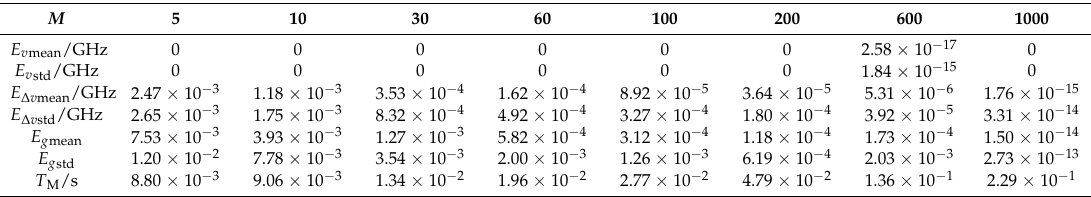
Table 4. Statistical results of errors in the key parameters extracted by the Voigt profile-based algorithm with different numbers of sample points, noise-free.